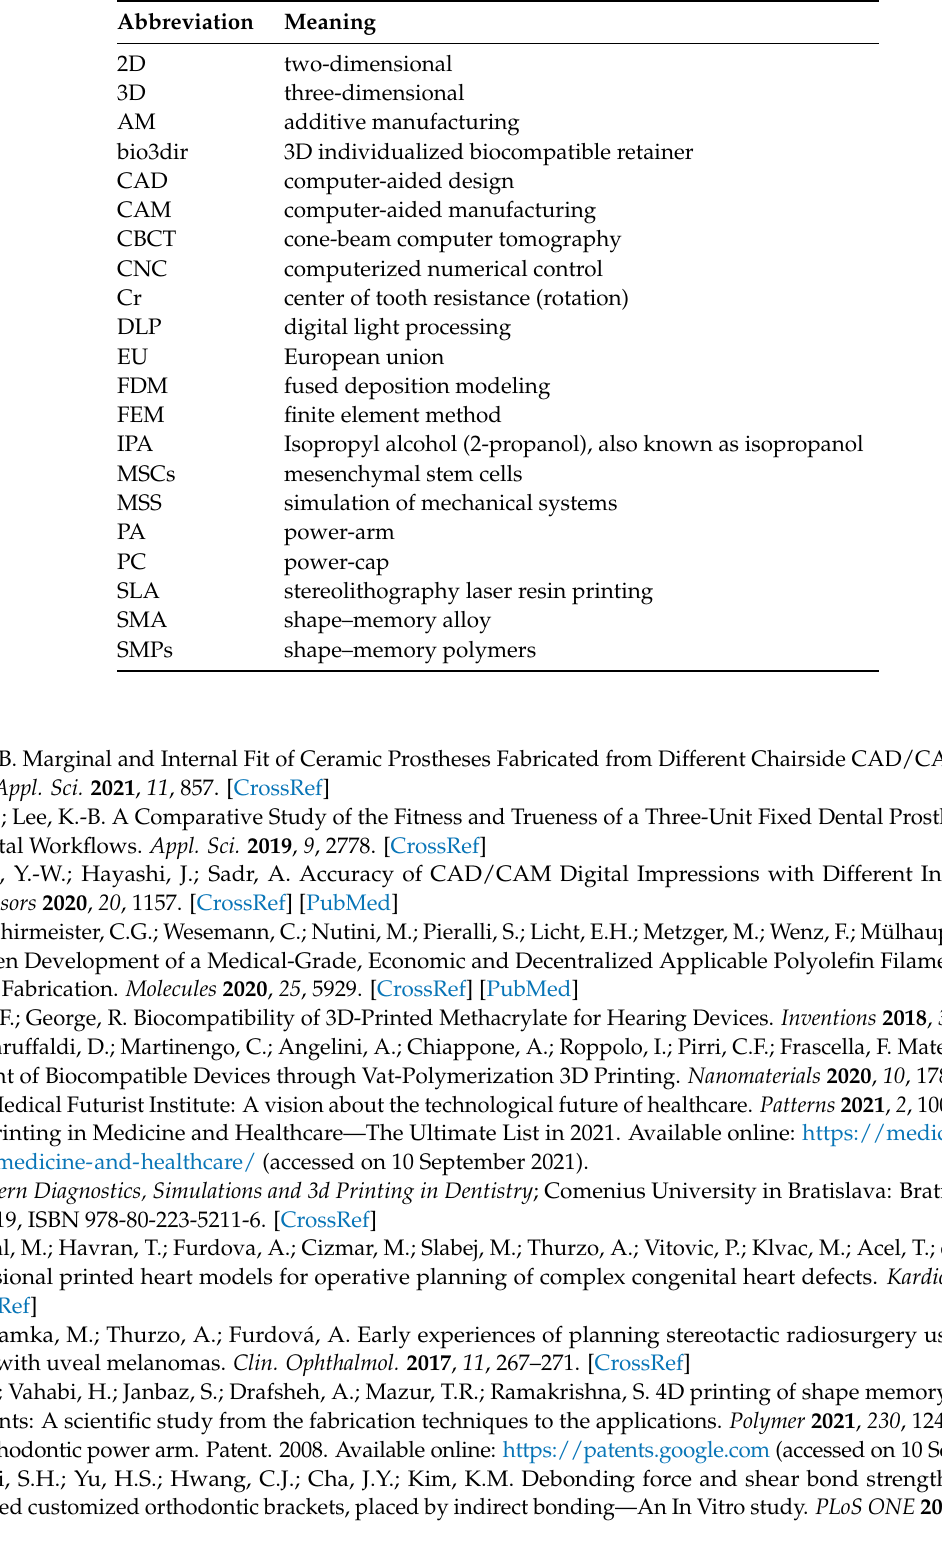
Table of used abbreviations in alphabetical